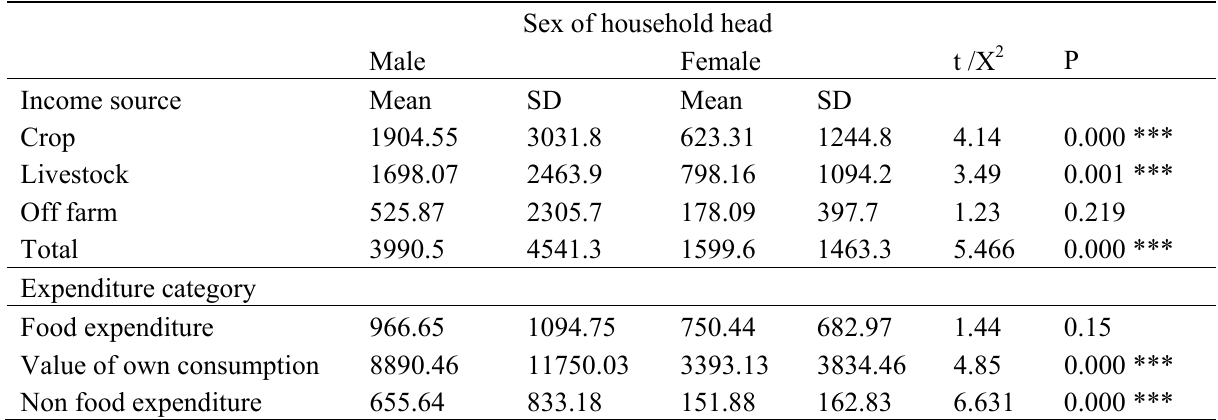
Table 2. Income and expenditure pattern by